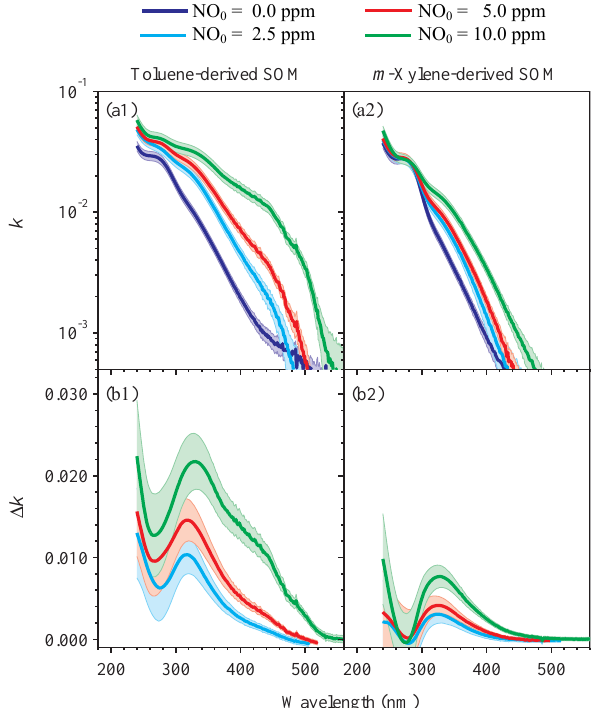
Figure 2. Absorptive component k of the refractive indices of (col- umn 1) toluene-derived SOMs and (column 2) m -xylene-derived SOMs for several different initial NO concentrations. Row 1 shows the k values, and row 2 shows (cid:49)k values (i.e., (cid:49)k = k − k NO The k values are derived from UV–Vis measurements (see main text). The shaded regions show confidence intervals of 10 to 90%, as calculated by propagation of individual uncertainties for the pa- rameters of Eq.